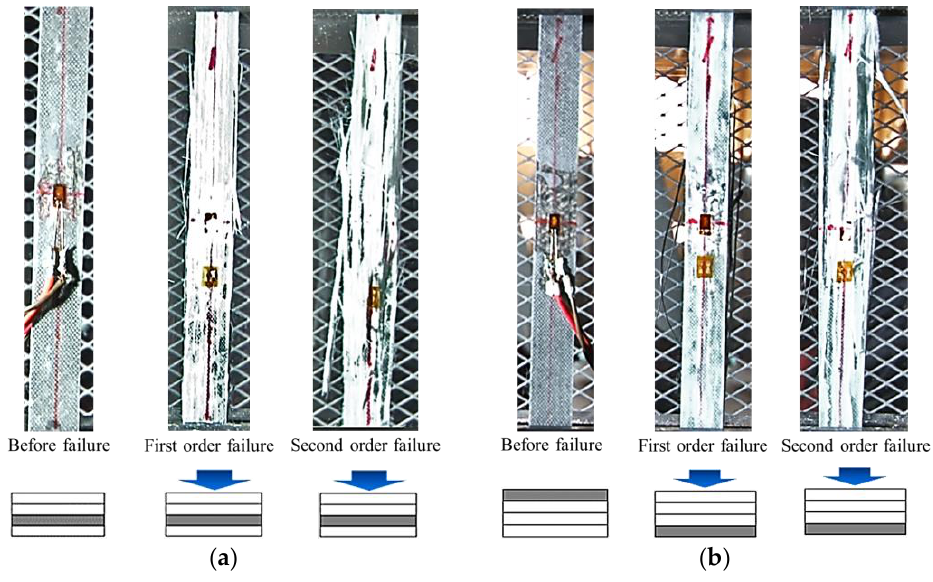
Figure 11. Failure process of interlayer hybrid composites: ( a ) [G/G/C/G]; ( b ) [G/G/G/C].